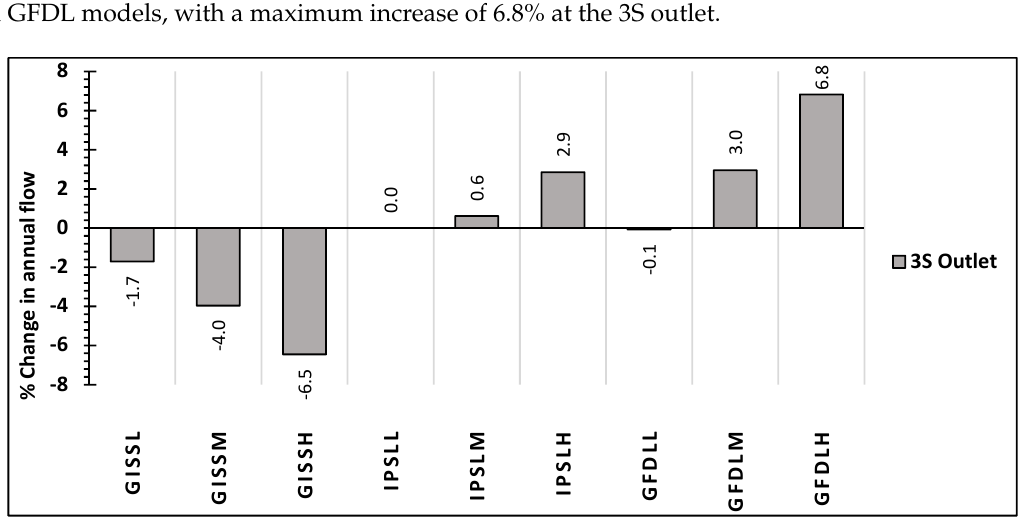
Figure 6. Percentage (%) change in average annual flow under three emissions scenarios (L—low, M—medium and H—high emissions) for the GISS, GFDL and IPSL models with respect to the baseline climate (BL) scenario at the 3S outlet.